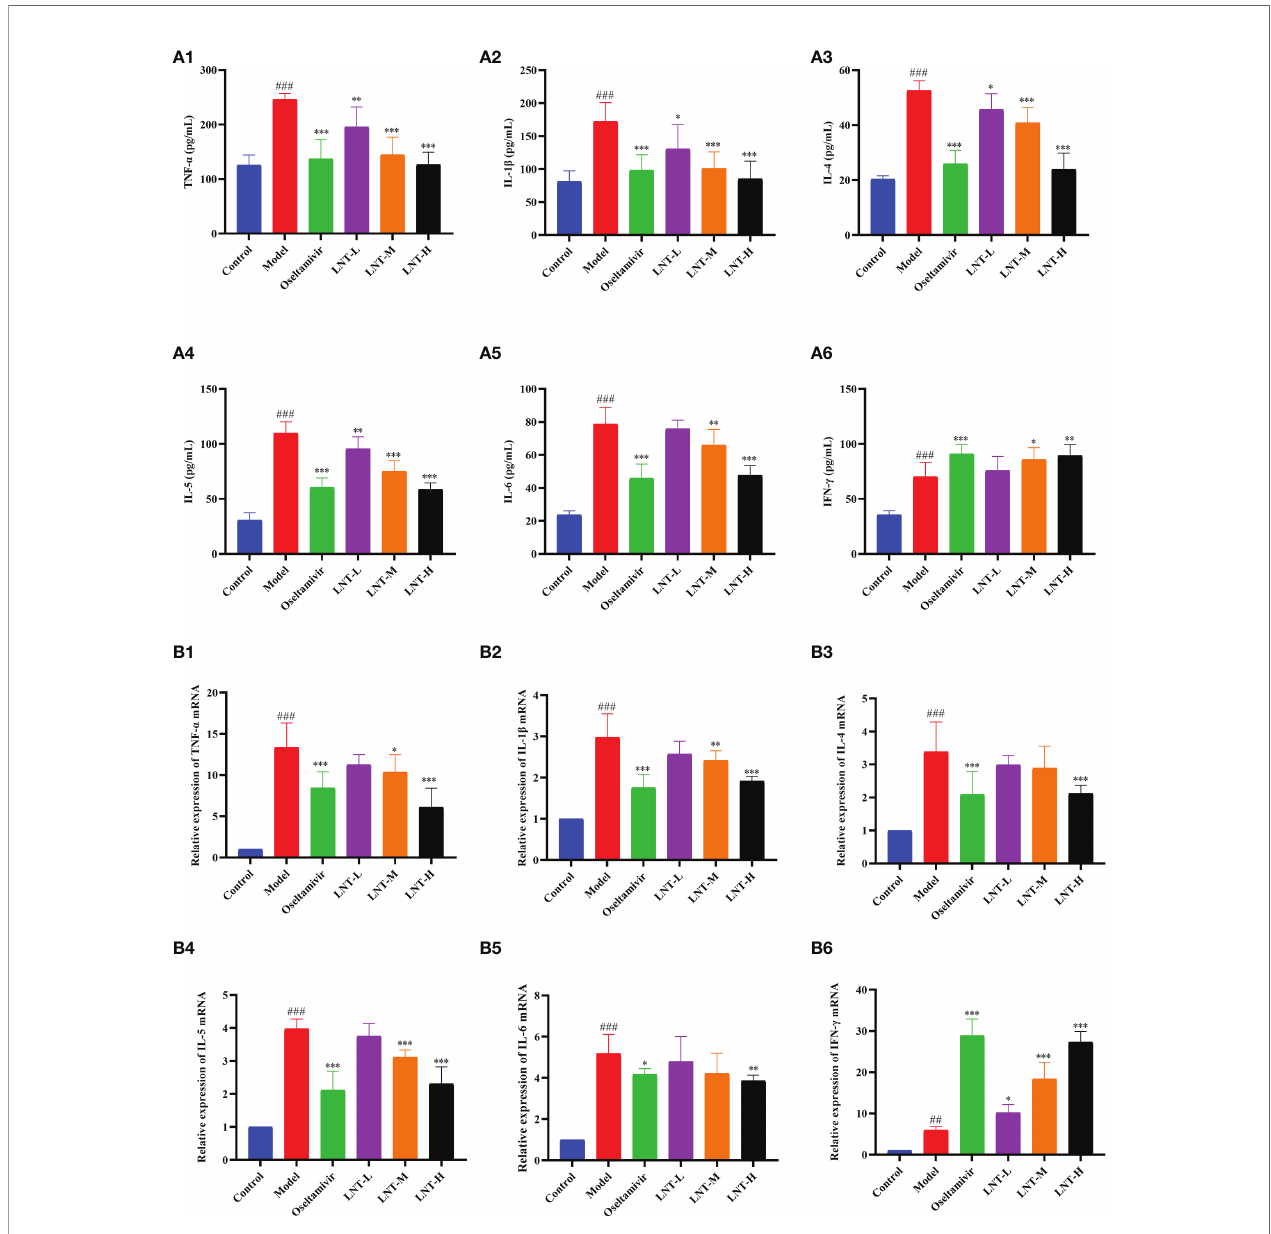
FIGURE 5 | Effects of LNT on cytokines in mice. The serum and lungs of 5 dpi mice were collected. Cytokines in the serum of mice were detected by ELISA method, and cytokines in the lungs of mice were detected by RT – qPCR. LNT decreased the levels of TNF- a , IL-1 b , IL-4, IL-5 and IL-6 in the serum (A) and lung (B) of mice, and increased the level of IFN- g . ### p < 0.001, ## p < 0.01, vs. the control group (n=10); *p < 0.05, **p < 0.01, ***p < 0.001, vs. the model group